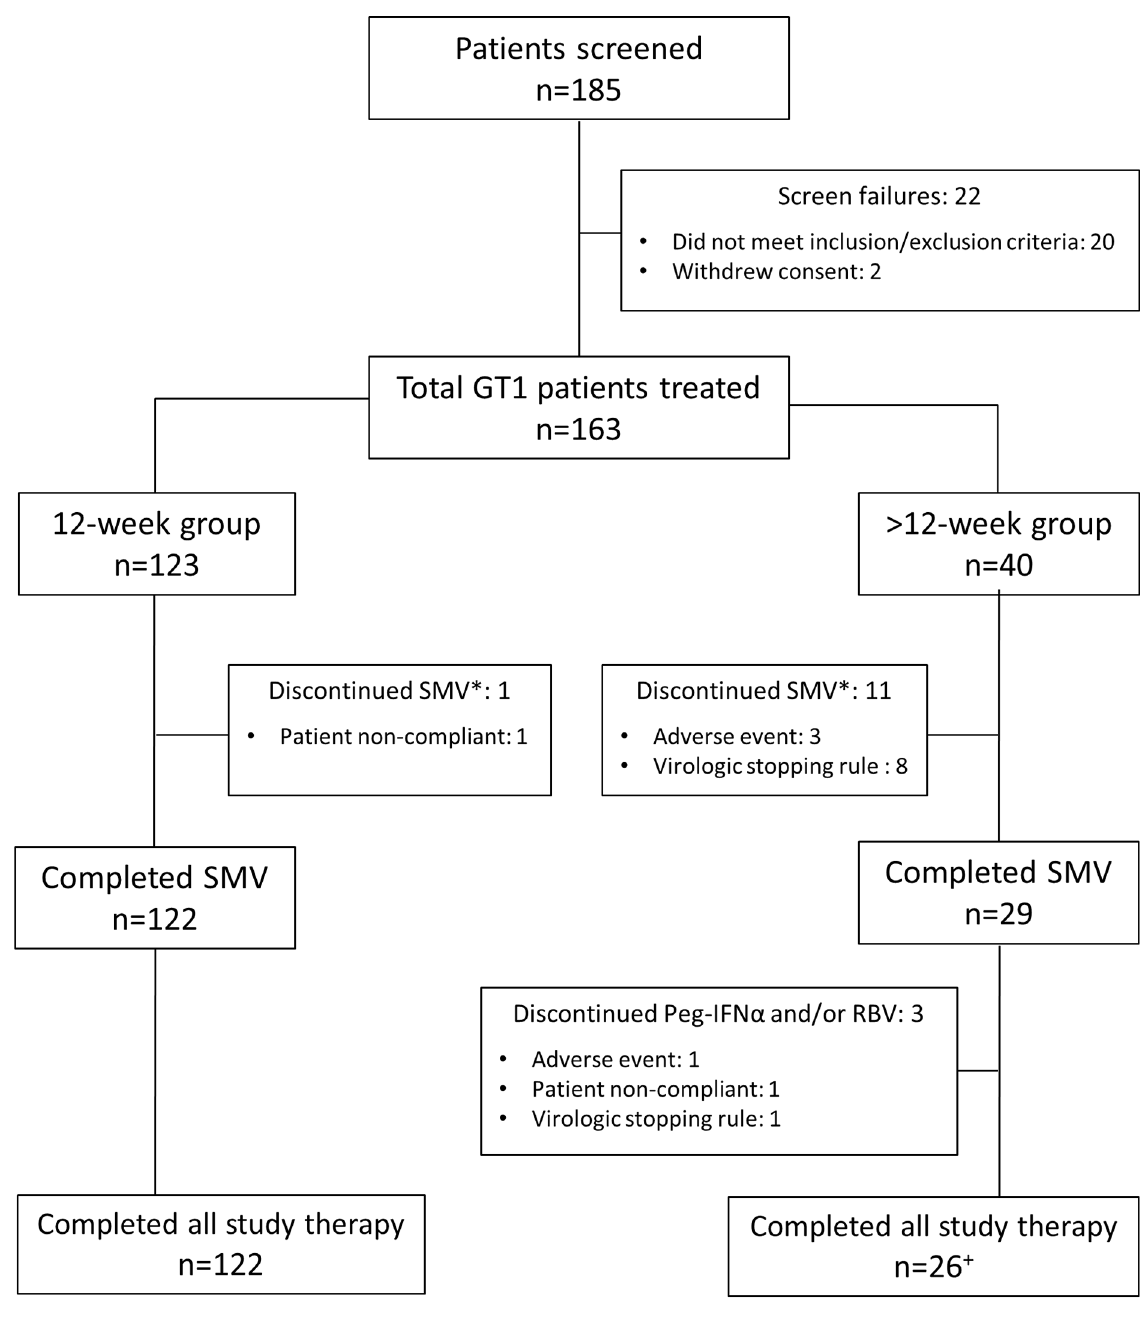
Fig 1. Patient disposition flow chart.